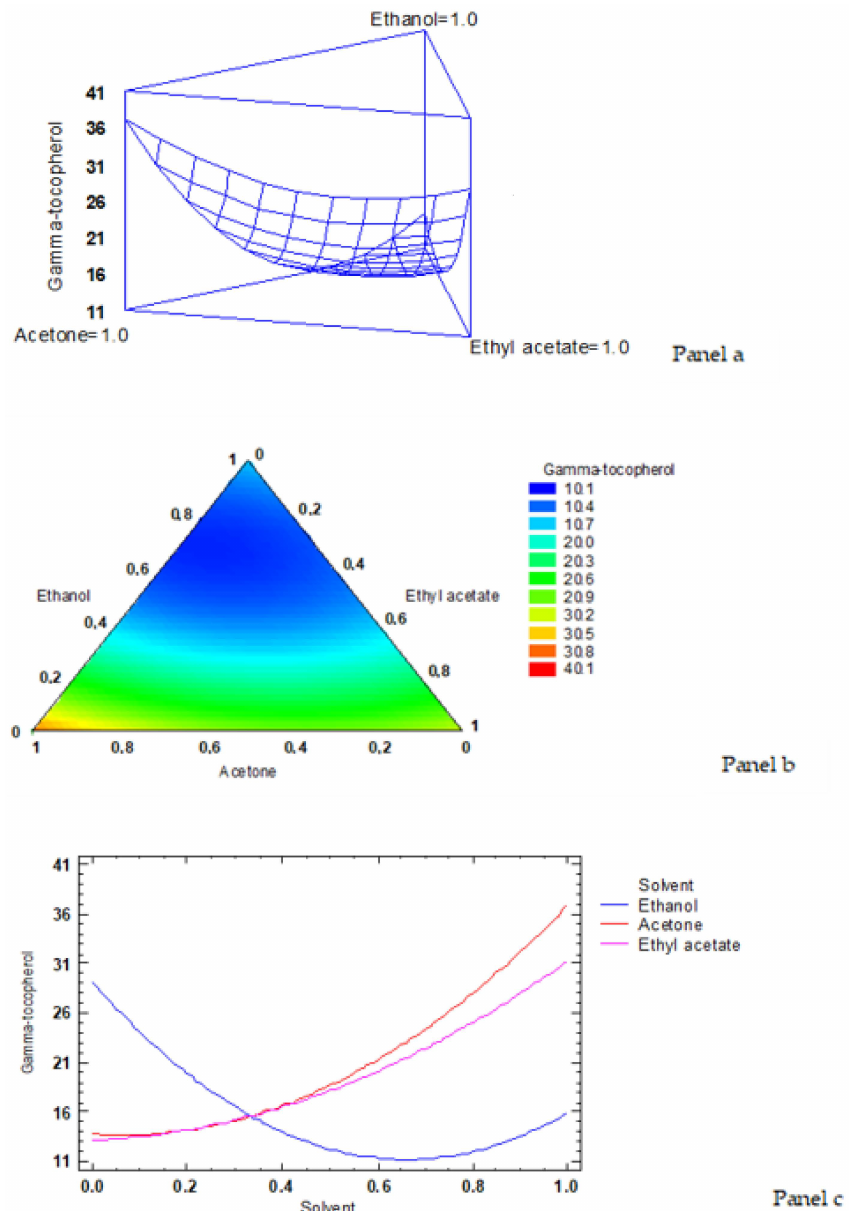
Figure 3. Application of the simplex-lattice design on the fitting model corresponding to the γ - tocopherol content (mg · kg − 1 lipids). Panel a : estimated response surface; Panel b : contours of estimated response surface; Panel c : trace plot for γ -tocopherol